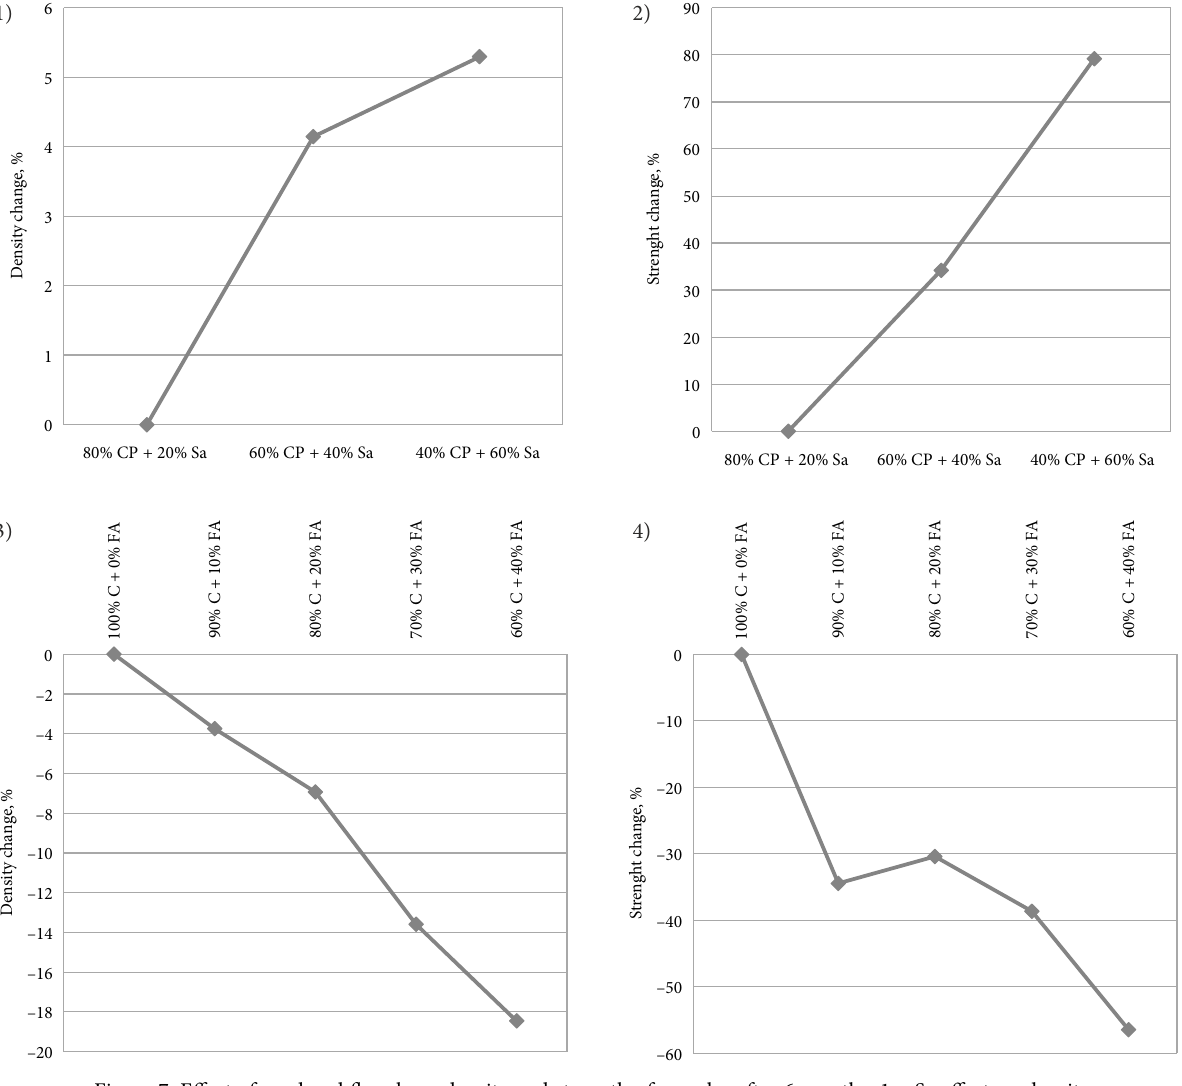
Figure 7. Effect of sand and fly ash on density and strength of samples after 6 months: 1 – Sa effect on density; 2 – Sa effect on strength; 3 – FA effect on density; 4 – FA effect on strength